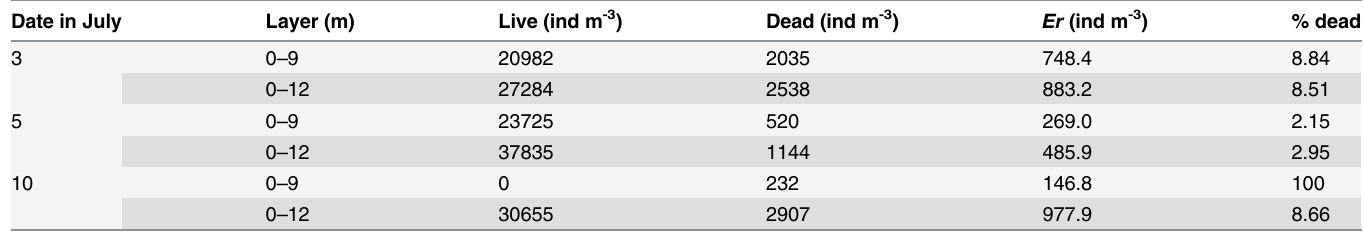
In situ sinking velocity of B . longirostris carcasses was calculated for each trap and each day, and it varied from 0.47 to 3.36 m d -1 (Table 4). The data were normally distributed (D 0.116, p > 0.20). The mean ± SD of 10 replicate in vitro carcass sinking velocity measurements was 134.26 ± 32.31 m d -1 (Table 5). The mean ± SD of 10 replicate measurements of carcass density was 1.070 ± 0.008 g ml -1 (Table 6). Table 3. Abundances and % dead of Bosmina longirostris in water column above the traps (0 – 9 m) and weighted mean for 0 – 12 m ( N i and y i ) in Lake